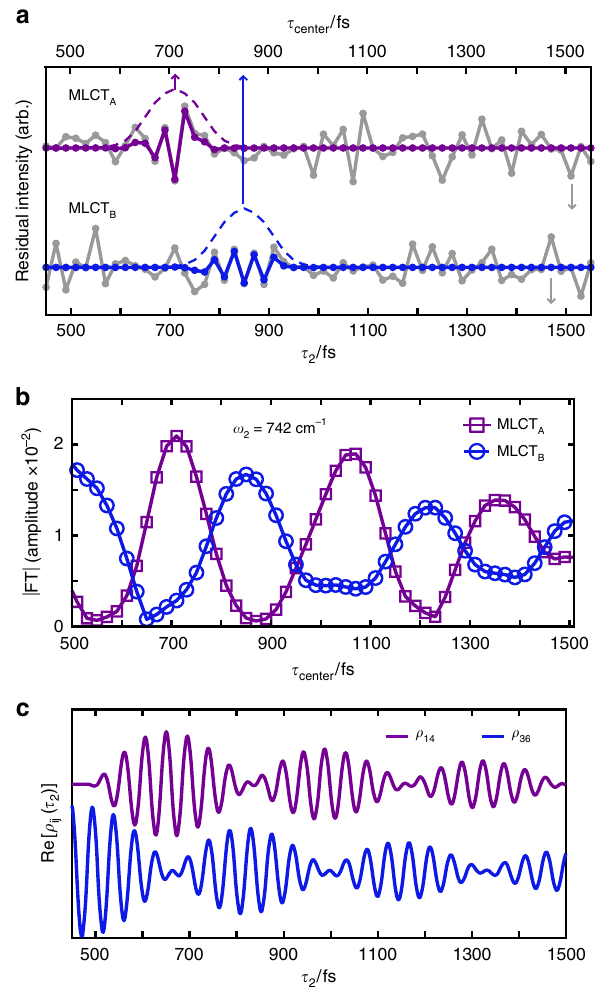
Fig. 5 Later MLCT relaxation dynamics: nonadiabatic internal conversion through vibronic coherence. a Residual intensity (gray) of the integrated ( ω 1 , ω ν 3 ) 2D peak areas for the COO vibration with MLCT A (top) and MLCT B (bottom) character; data are offset for plotting. Examples of the temporal fi lters (purple/blue, dashed) used in short-time FT analysis (FWHM = 120fs, centered at τ center (top axis)) of the τ 2 -dependent residual intensity. The purple window ( τ center = 710 fs) highlights the ν Ru-bpy (742cm − 1 ) coherent beating with ν COO having exclusively MLCT A character while at a later delay ( τ center = 850fs) the blue window shows the ν Ru-bpy coherence having exclusively MLCT B character. b Short-time FT results reveal the oscillatory electronic character of the ν Ru-bpy coherence signature between MLCT A and MLCT B with 340 ±40fs periodicity. c Simulation of the coherence block in the Red fi eld relaxation tensor for ρ 14 (purple) and ρ 36 (blue) during τ 2 with an 800fs coherence decay time where ω 14 = ω 36 = 742cm − 1 and a 50cm − 1 nonadiabatic coupling reproduces electronic oscillatory behavior for the vibronic coherence involving ν Ru-bpy with MLCT A and MLCT B (data offset). See Supplementary Note 5 for discussion of Red fi eld relaxation dynamics and Supplementary Note 7 for simulation